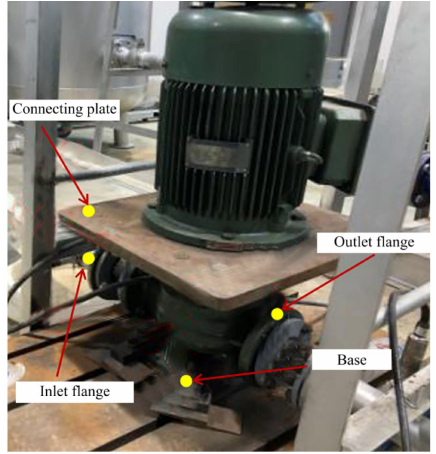
Figure 7. Vibration measuring point